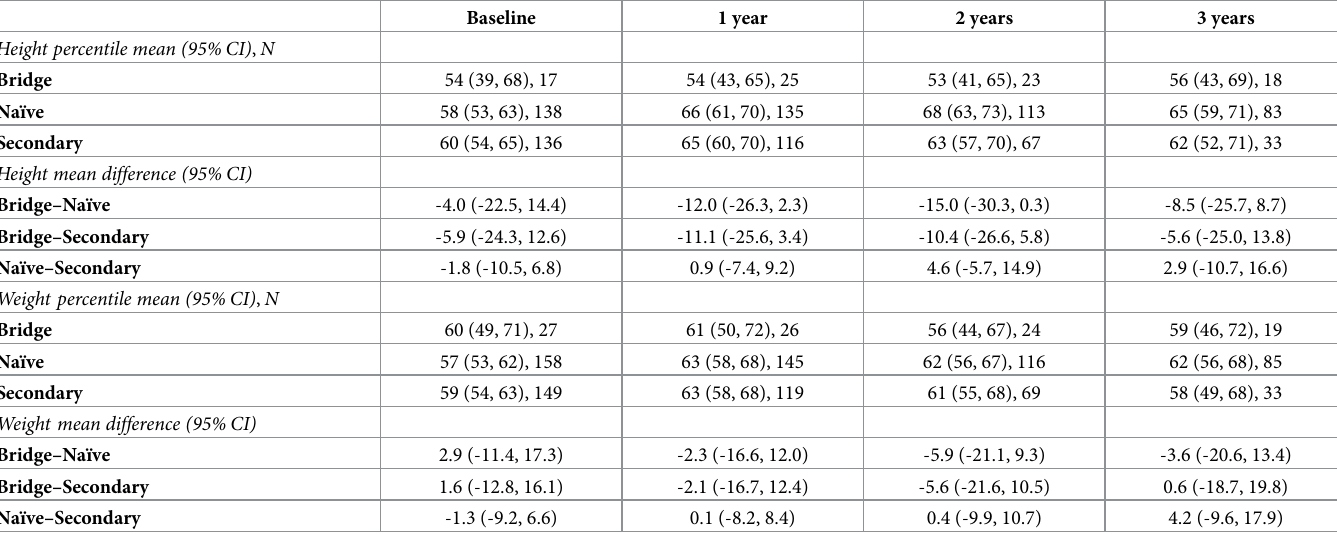
Table 3. Height and weight percentile by group and group difference.